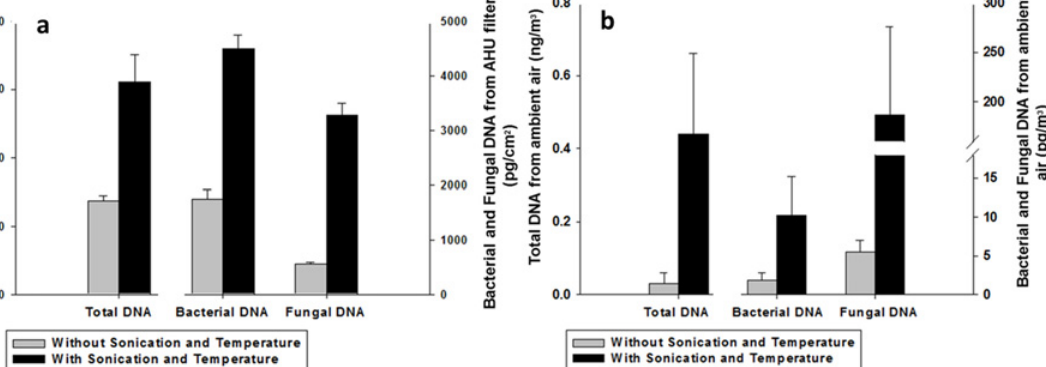
Fig 4. Improving DNA yield with additional heat and sonication lysis. Additional sonication and thermal lysis show improved DNA yield for (a) — AHU filter samples and (b) – ambient air samples as measured by the Qubit fluorometer for total DNA (left bar, left axis) and by qPCR for bacterial (middle bar, right axis) and fungal (right bar, right axis) DNA ( N =